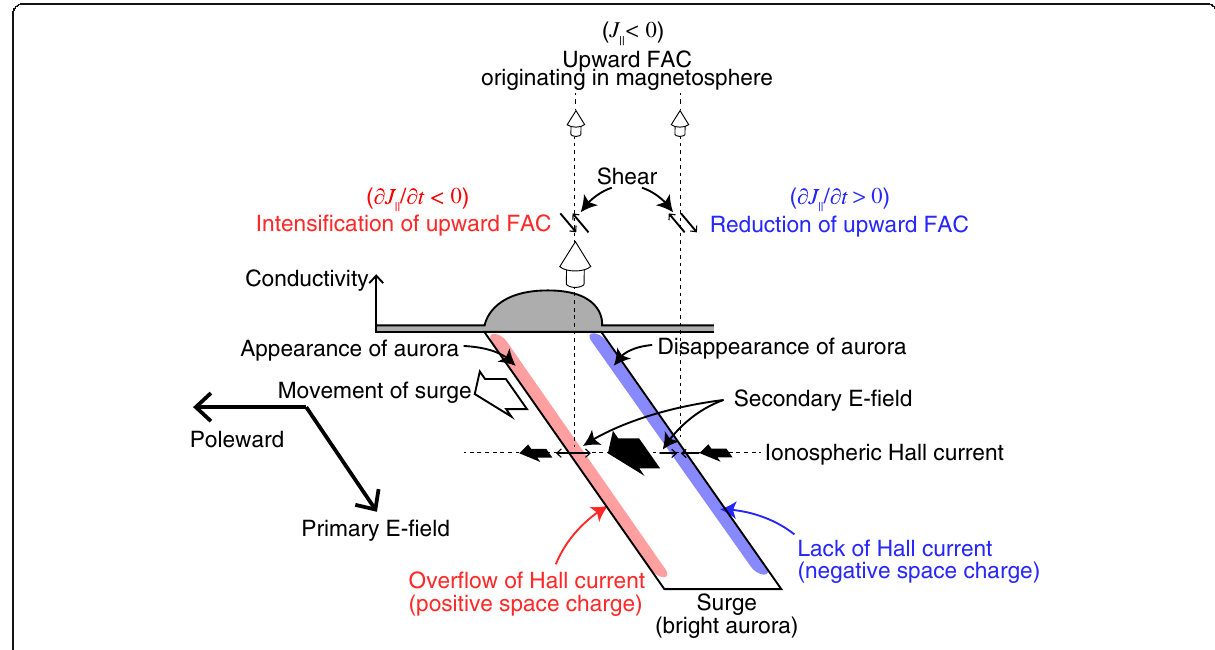
Fig. 14 Schematic drawing for the formation of the westward traveling surge. (Ebihara and Tanaka 2018)